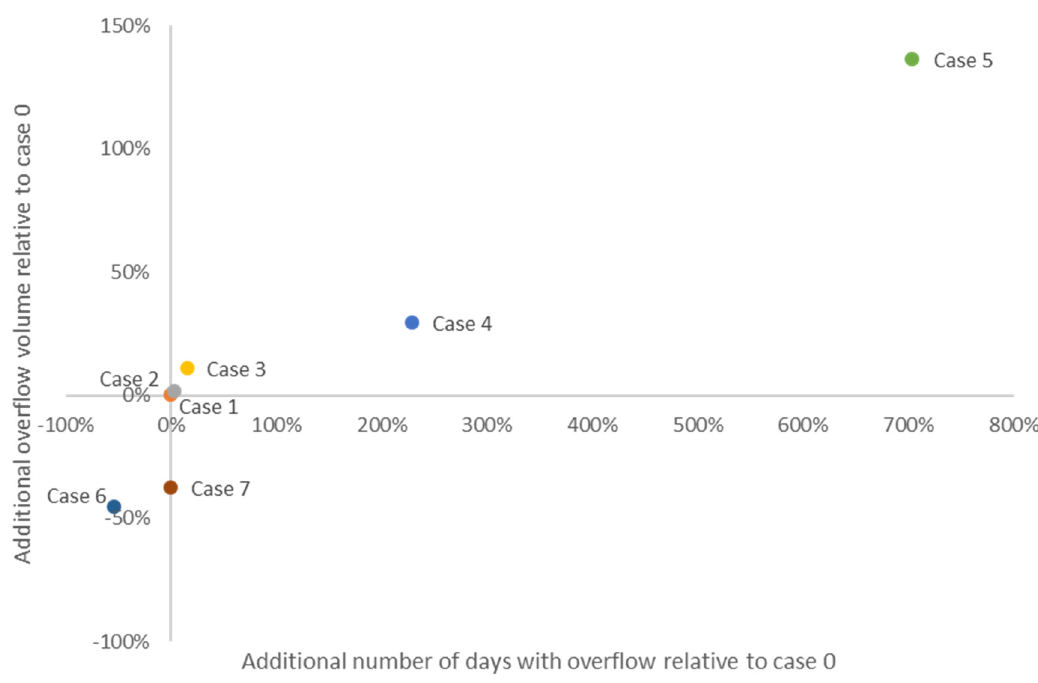
Figure 3. Relative differences in number of days with overflow and overflow volumes for cases 1–7 compared to case 0.